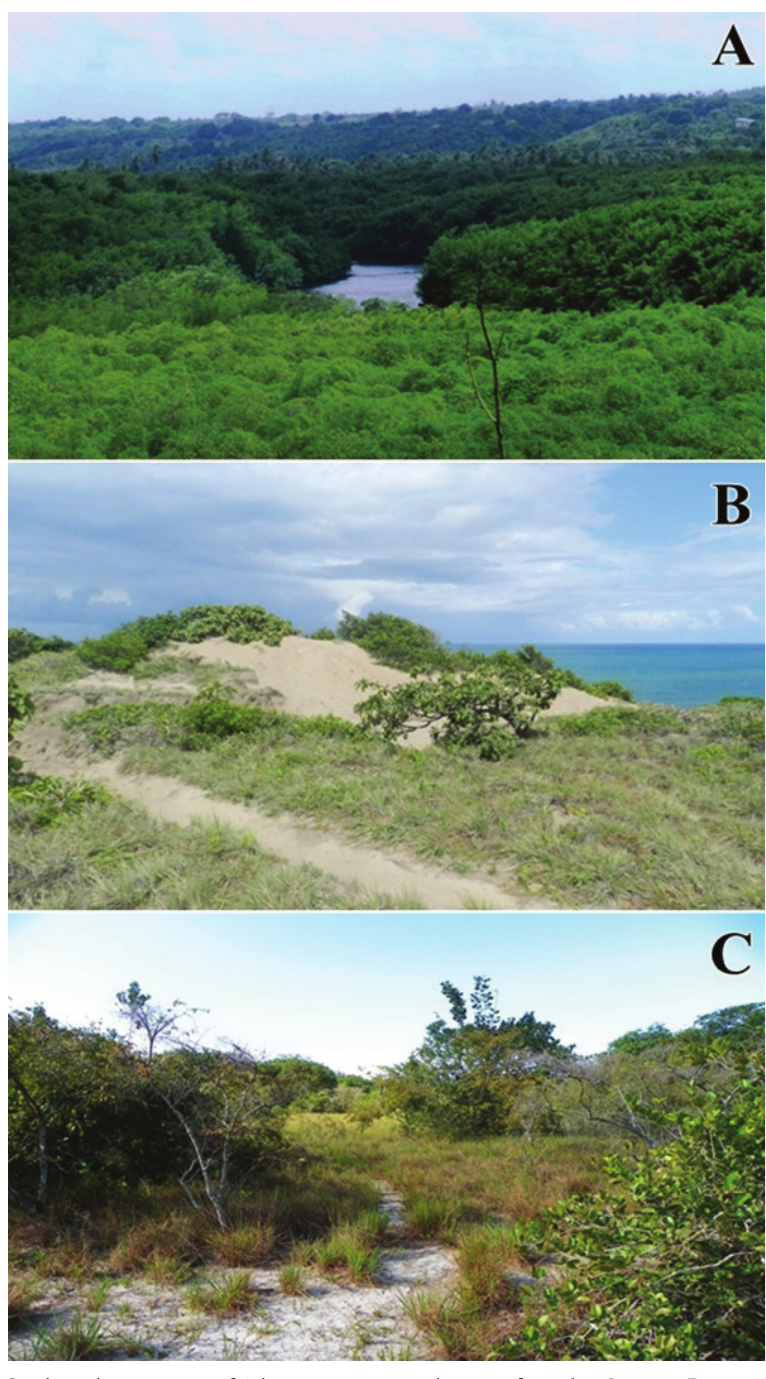
Figure 3. Phytophisiognomies of Atlantic Forest in south coast of Paraíba. A Forest B Restinga C Sa- vanna enclave (Tabuleiro). Photograph credits: Ivan L. Sampaio ( A, B ), Frederico G. França ( C